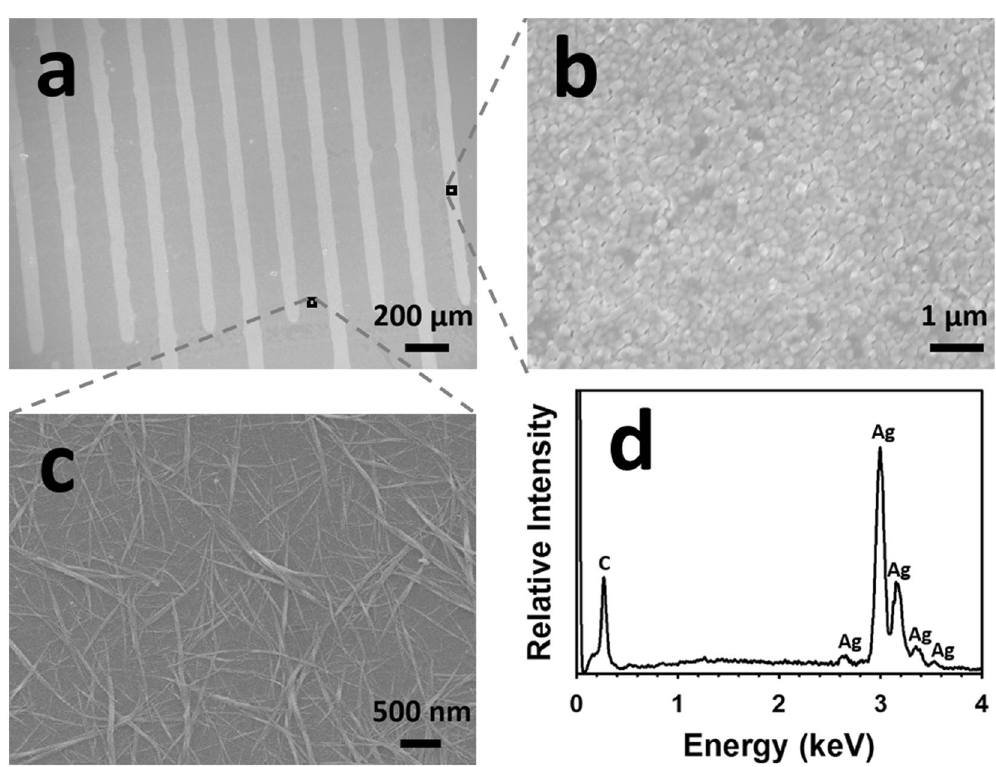
Figure 2. Scanning electron microscopy (SEM) and energy dispersive X-ray spectroscopy (EDX) analyses of a sensor before the Ag-to-Au conversion. ( a ) SEM image of the sensor; ( b ) SEM image focusing on an IDE finger of the sensor; ( c ) SEM image focusing on the SWCNT-selector complexes between two adjacent IDE fingers; ( d ) EDX pattern of the specimen shown in ( b